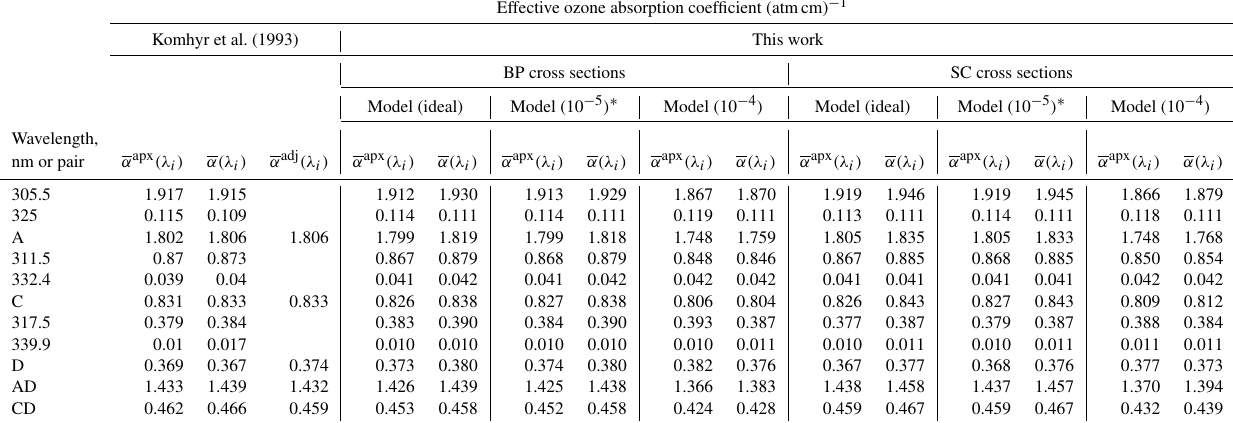
Table 6. Dobson wavelengths and ozone absorption coefficients.